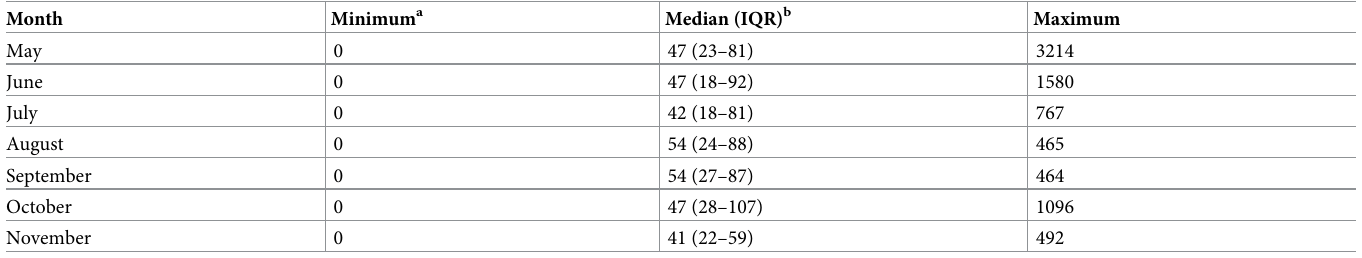
Table 1. Median distance (in kilometres) between pairs of locations visited by a sample of horses in Ontario, Canada between May and November 2015. Month Minimum a Median (IQR)